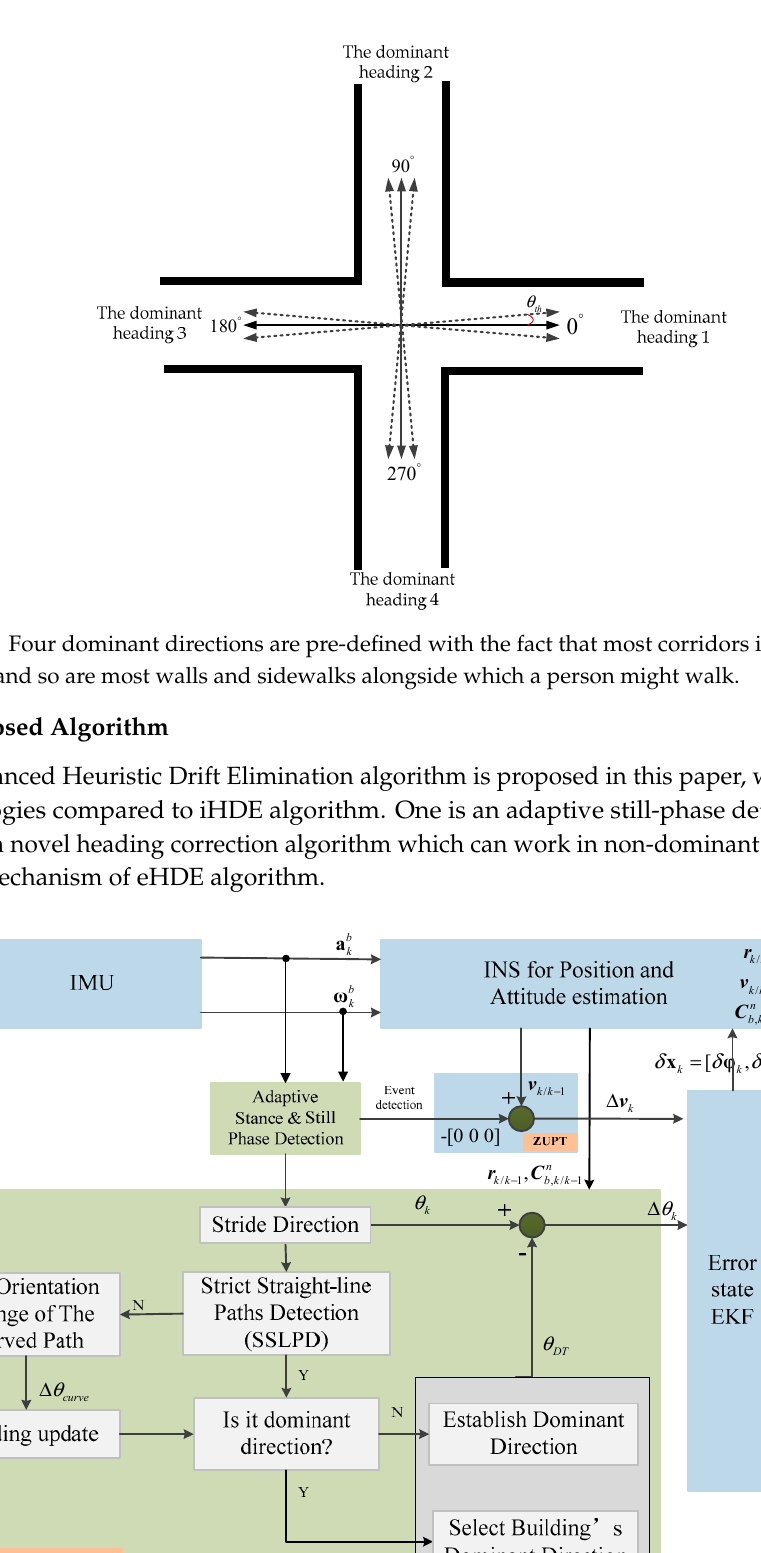
9 of 23 Figure 4. The zero-velocity interval's detection results for the fixed threshold-based detection algorithm when a pedestrian walks at different speeds. The blue line denotes the gait, the large values indicate the still-phase, while the small values indicate the swing-phase; the red dots denote the start point of the still-phase; and the green line denotes the standard deviation of acceleration. 3.2. The Heuristic Drift Elimination and its Improved Algorithm The original HDE algorithm aims to reduce the accumulated error in heading using only a body- attached IMU; it makes use of the fact that most corridors in buildings are straight and so are most walls and sidewalks alongside which a person might walk, and an I-control is used for correcting the gyro signals when the algorithm assesses that the user is walking along a straight line [23]. Instead of